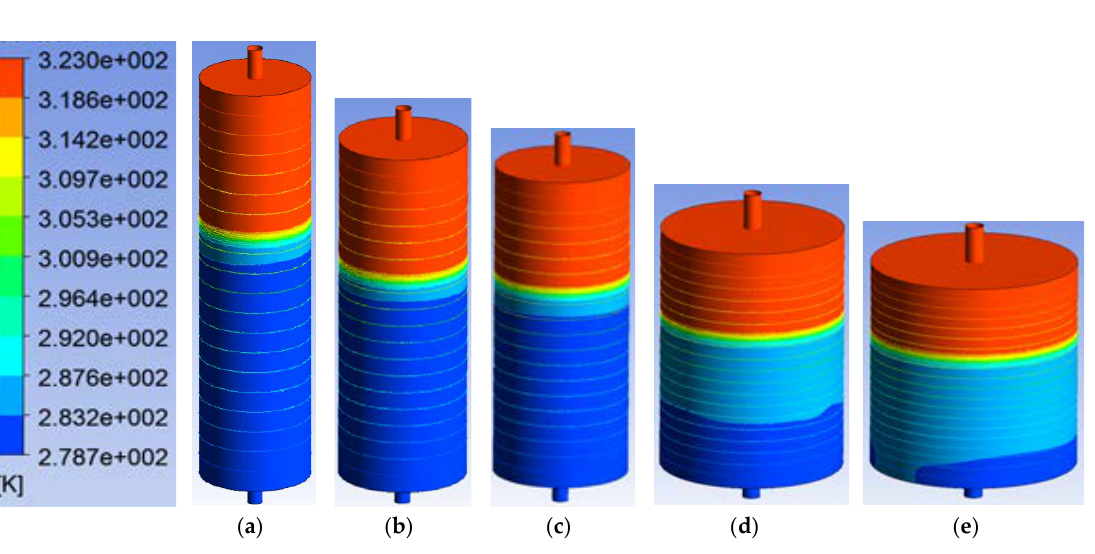
Figure 6. Simulation results of different TES systems after 1600 s: ( a ) TES-1; ( b ) TES-2; ( c ) TES-3; ( d ) TES-4; ( e ) TES-5.